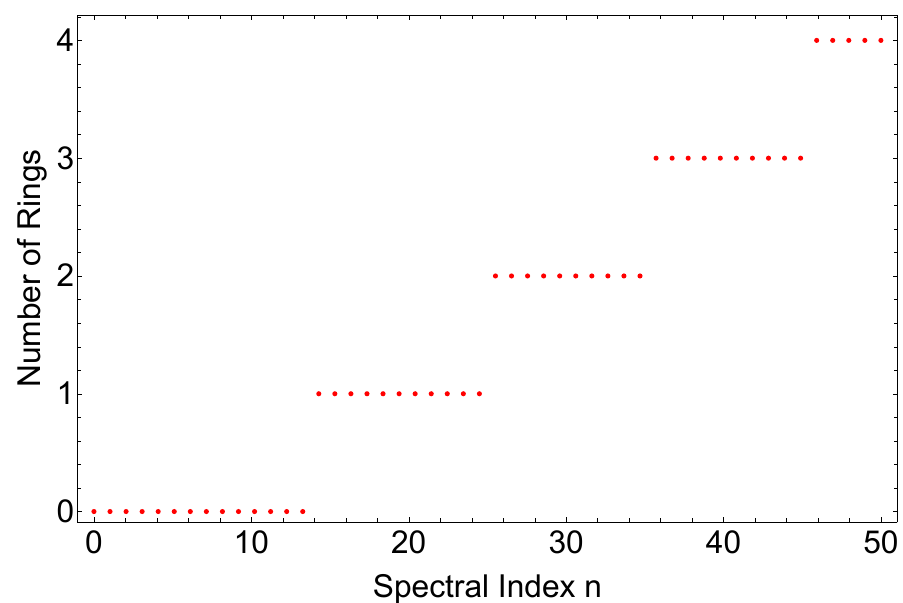
Figure 4. Plot of the number of visible rings for different values of the spectral index n (red dots). To calculate the number of rings, we have adopted the algorithm described in Section 4 (Meth- ods). Notice that since we consider only paraxial pulses, we have limited our analysis to only the paraxial region of the pulse, i.e., the region close to its center. For this plot, m = 1 and α = 1 have been